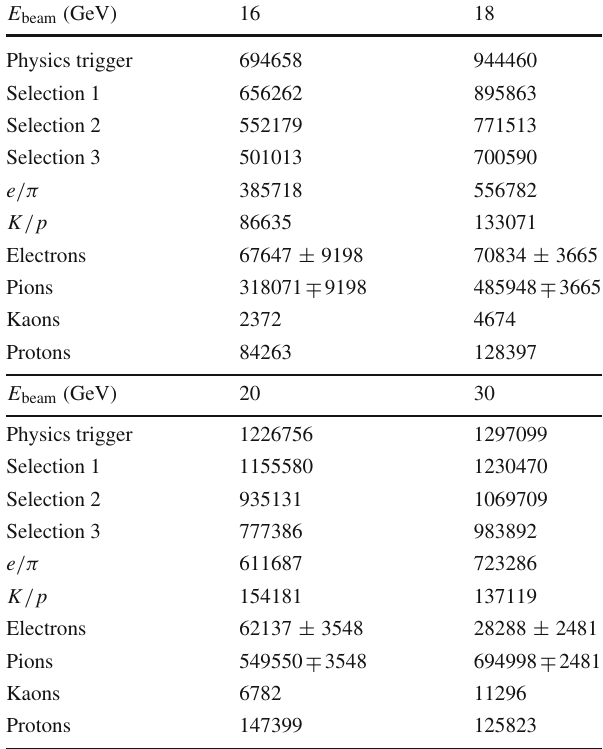
Table 2 Numbers of experimental data events collected (Physics Trig- ger)andretainedintheanalysisselectionstepsforeachofthefourbeam energies. The number of events identified as electrons, pions, kaons and protons is reported. Selection criteria and determination of statistical uncertainties on the number of electrons and pions are discussed in the